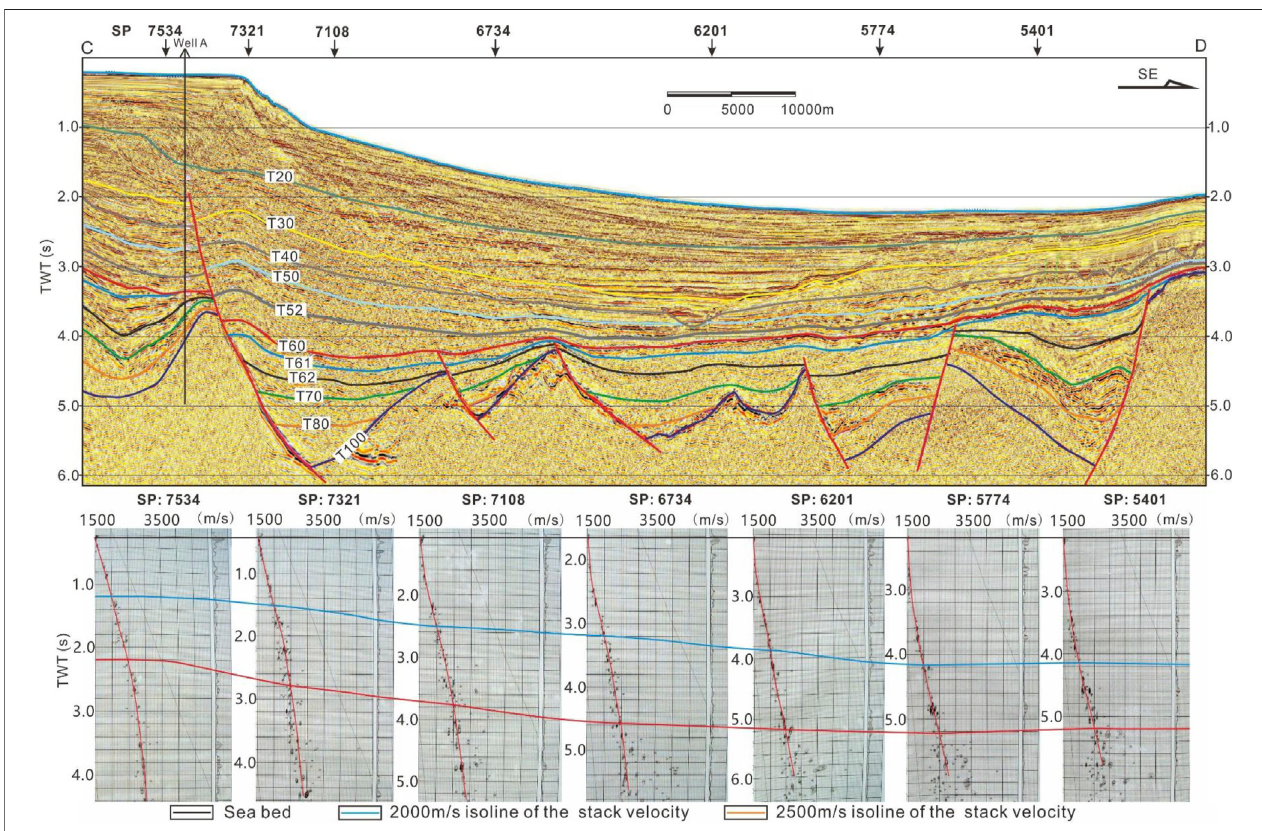
FIGURE6 | Top interpreted seismic cross-section, showing thesite ofWell Aand the selectedpoints for the stacking velocity analysis.(Bottom) Selectedstacking velocity spectra, and the 2000 m/s and 2,500 m/s isolines of the stacking velocity. The cross section location is shown in Figure 1 .